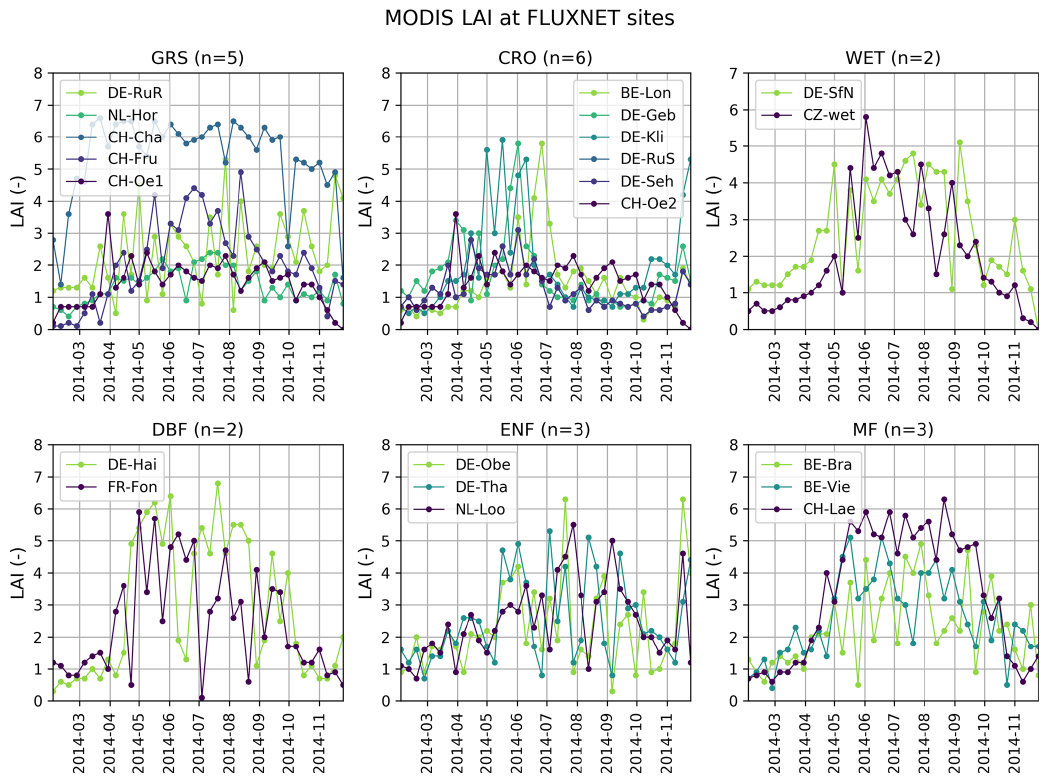
Figure 9. Seasonal variation of the MODIS LAI at individual FLUXNET sites with different land use